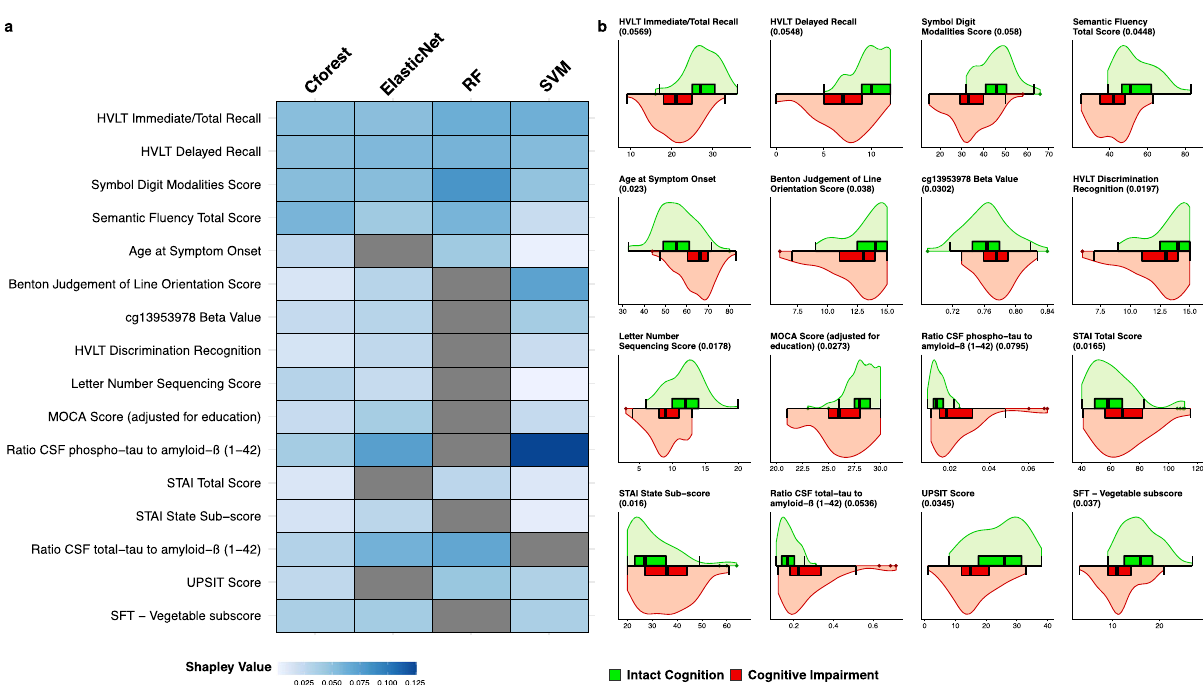
Fig. 3 Variable importance in predicting cognitive impairment outcome. Variables included across three or more ML models for prediction of the cognitive impairment outcome using combined clinical and biological variables. a A heatmap of global Shapley importance. Darker blue re fl ects higher Shapley value and more important variables in the model. Variables not included in a particular model are shown in gray. b Dual violin and box plots of raw values of each variable between groups. Average global Shapley value importance for each variable is shown in brackets next to each variable name. Boxes represent median, Q1 and Q3 of the interquartile range (IQR) and whiskers display 1.5× IQR below and above Q1 and Q3, respectively. HVLT Hopkins Verbal Learning Test, MOCA Montreal Cognitive Assessment, CSF cerebrospinal